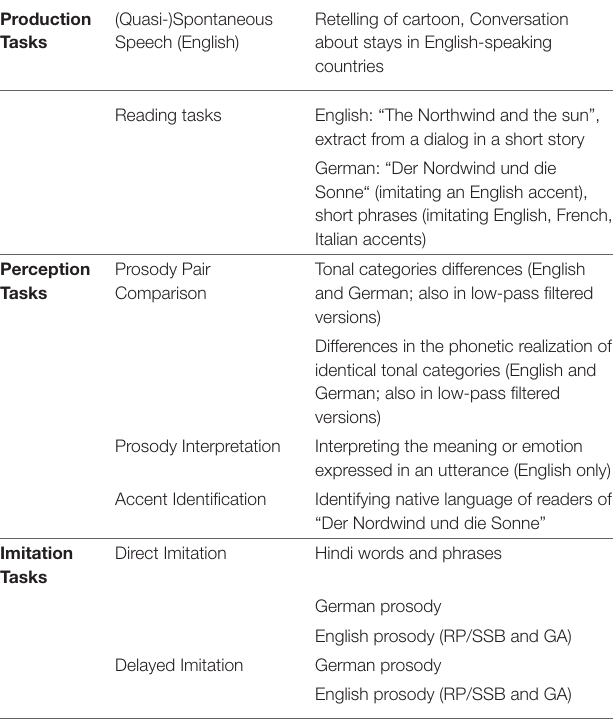
TABLE 2 | Tests of phonetic ability [(Jilka, 2009a,b), in (Dogil and Reiterer, 2009)]. Production